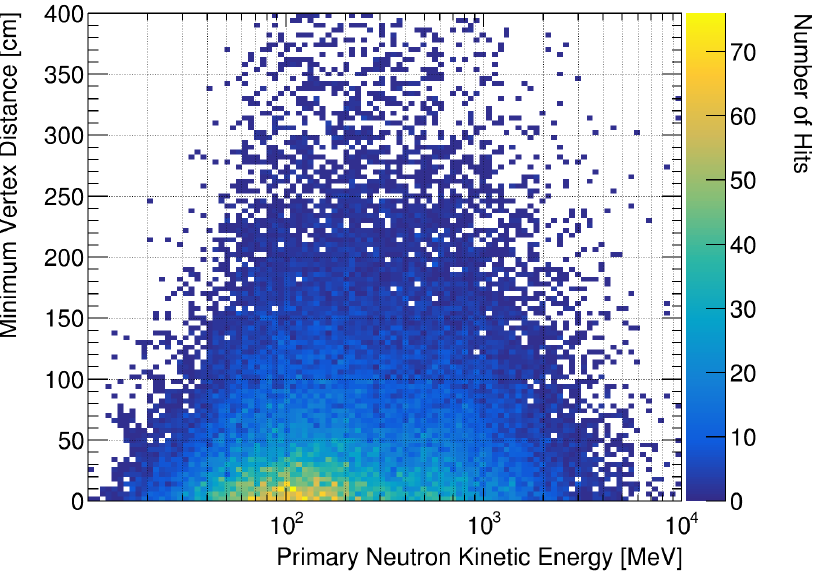
Figure 28. The minimum distance between the neutrino vertex and the neutron-induced proton track, as a function of neutron kinetic energy. Produced with 100,000 initial neutrino events simulated by